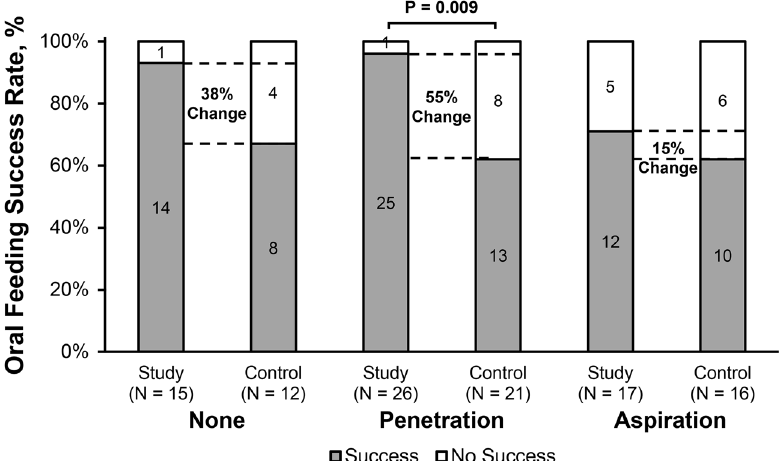
Figure 3. No penetration or aspiration: PAS = 1, Penetration: PAS = 2 to 5, Aspiration: PAS = 6 to 8. In the figure legend, success is defined as independent oral feeding, and no success as any tube feeding. Numbers within bars represent n-values of infants. Note in those infants with laryngeal penetration, feeding success was greater in the study group. Although not statistically significant, infants without penetration or aspiration may also clinically benefit from the study approach as indicated by 38% higher oral feeding